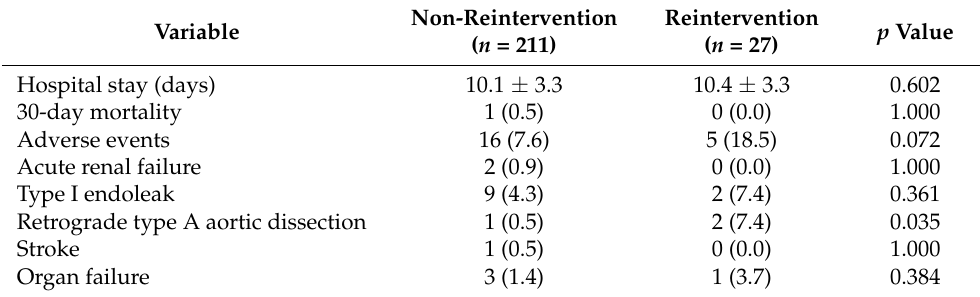
Table 3. In-hospital and 30-day